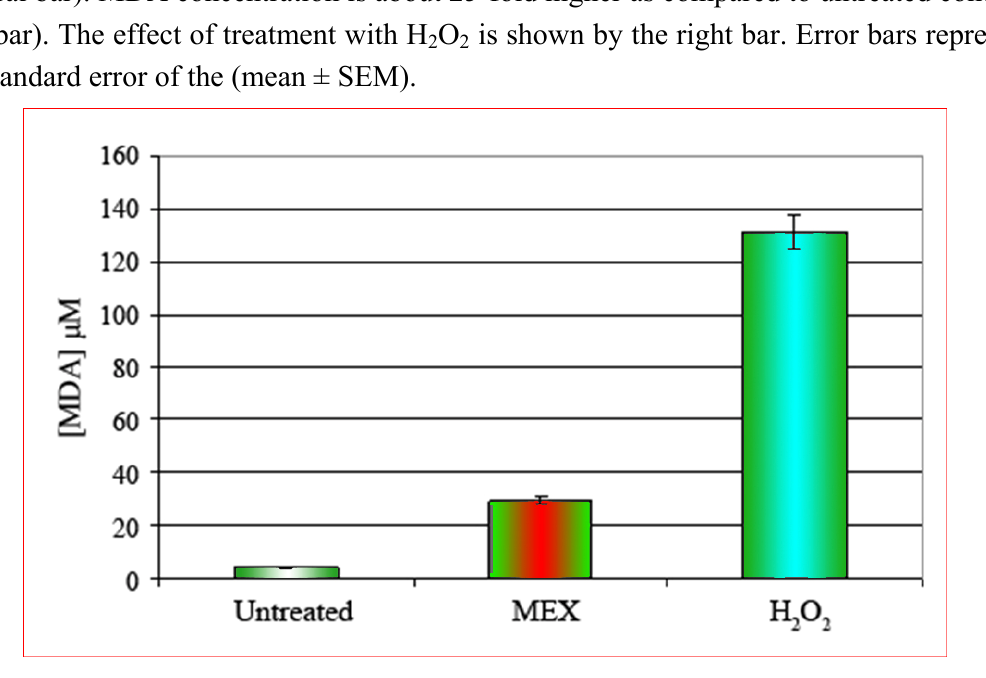
O is shown by the right bar. Error bars represent 2 2